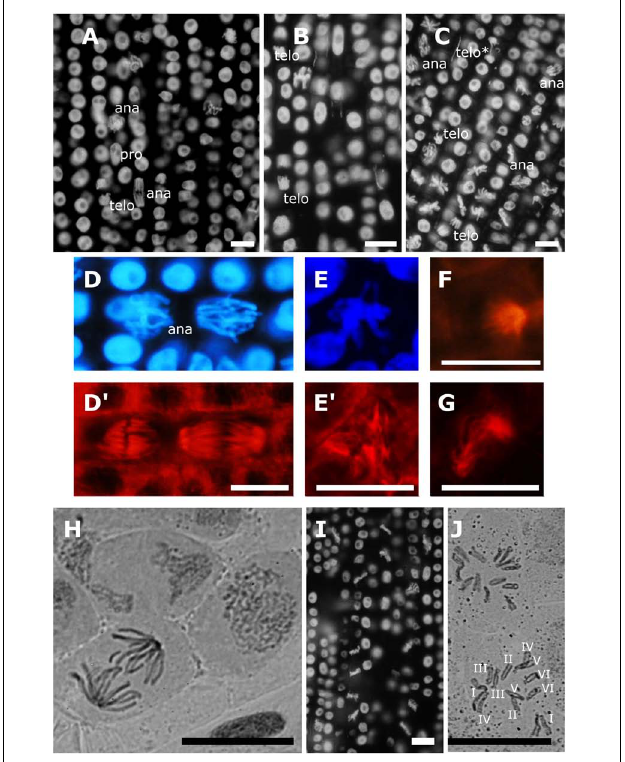
FIGURE 1 | Effects of 12 h treatments with Allyl-isothiocyanate (AITC) and Microcystin-LR (MCY-LR) on chromatin and MT organization. (A–D,I) mitotic phases (pro- prophase, ana- anaphase, telo- telophase/cytokinesis) are labeled except metaphases. Chromatin is labeled with 4 (cid:48) ,6 (cid:48) -diamidino-2-phenylindole (DAPI) in panels A–E,I . MTs are labeled with anti- β -tubulin in panels D’,E’,F,G . (A) control lateral root tip, no metaphase synchronization is observed; (B) treatment with 10 µ M AITC; (C) treatment with 10 µ M MCY-LR, showing the abundance of metaphase cells. (telo ∗ ) is an aberrant telophase with a lagging chromosome (see detail on Supplementary Figure S2 ). Normal chromatin (D) and mitotic spindle (D’) organization in control cells. (E–G) alterations induced by the combined treatment with 10 µ M AITC and 10 µ M MCY-LR: (E’) tripolar spindle with its corresponding metaphase chromatin organization (E) ; (F) monopolar spindle; (G) C-shaped spindle. (H) control cells, chromosome preparation/ carmine acetate staining. Chromosomes are decondensed, no metaphase synchronization is observed. (I) synchronization of cells in metaphase and hypercondensation of chromosomes after combined treatment with 10 µ M AITC and 10 µ M MCY-LR. (J) chromosome preparation/ carmine acetate staining after combined treatment with 10 µ M AITC and 10 µ M MCY-LR. Typical, distinct V. faba chromosomes are seen, 2 n = 12. Scalebars: 10 µ m.